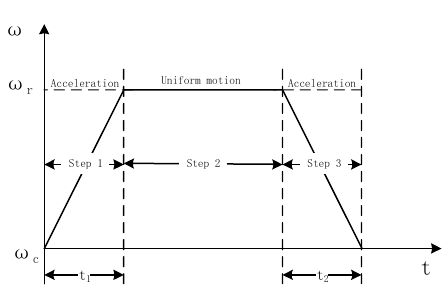
Figure 5. Rotation process.